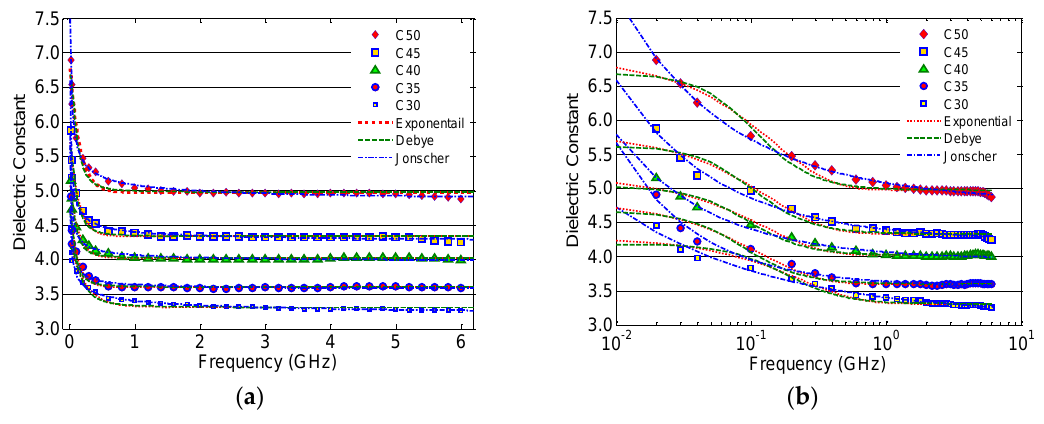
Figure 6. Dielectric characterization of GB concrete via curve fitting to measured data using the first-order exponential model, Debye model, and Jonscher model, expressed in ( a ) linear scale; ( b ) log-frequency scale.